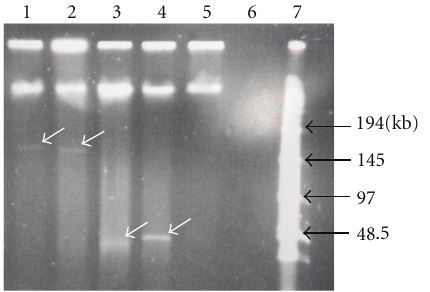
Figure 4: PFGE Analysis of megaplasmid content of total DNA of S. salivarius strains G32 (lane 1), 20P3 (lane 2), S. dysgalactiae strains 67 (lane 3), and 61 (lane 4), and S. pyogenes strain FF22 (lane 5). Lane 6 was left blank and lane 7 contained low range PFG marker (New England Biolabs). Megaplasmid bands are indicated with white arrows and marker sizes are indicated to the right of the